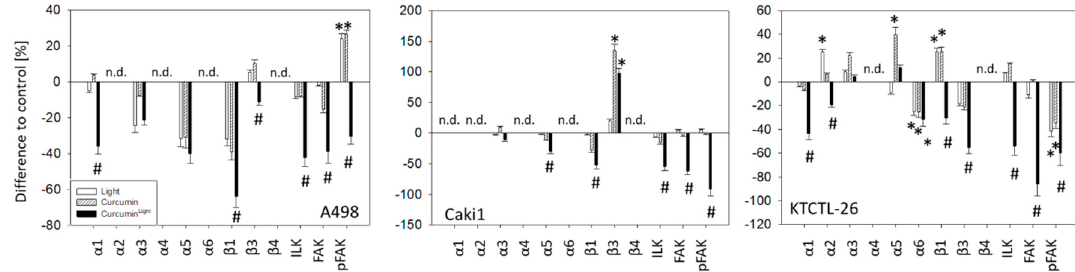
Figure 8. Pixel density of Western blot of α and β integrins, ILK and pFAK, depending on the influence of curcumin (0.2 µg/mL), light, or curcumin Light on A498, Caki1, and KTCTL-26 cells. Values are means ± SD, n = 3. * indicates significant difference to the untreated control (line drawn at 0%) and # indicates significant difference to light alone or curcumin alone. n.d. = not detectable.